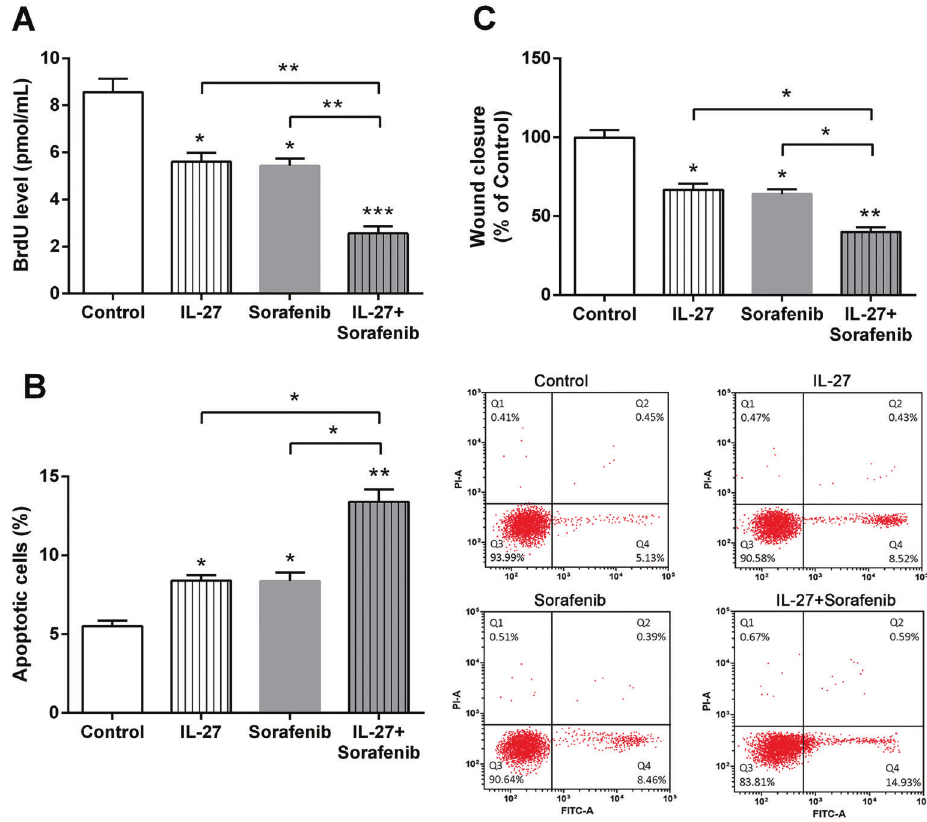
Figure 5. Effect of IL-27 (50 ng/mL) and sorafenib (2 m M) alone or their combination on T24 cells. Cells cultured with blank medium acted as control. A , Cell proliferation by BrdU assay. B , Cell apoptosis by fl ow cytometry. C , Cell migration by scratch assay. Data are reported as the mean ± SE of 3 independent experiments. *P o 0.05; **P o 0.01; ***P o 0.001 compared to control unless indicated otherwise ( t -test). IL-27: interleukin 27; BrdU: